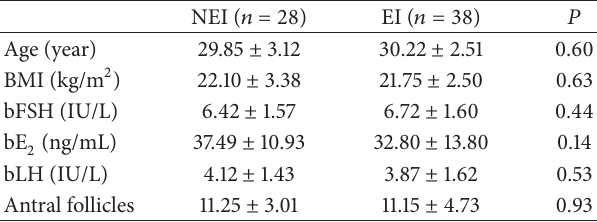
Table 1: Clinical parameters of the NEI and EI group